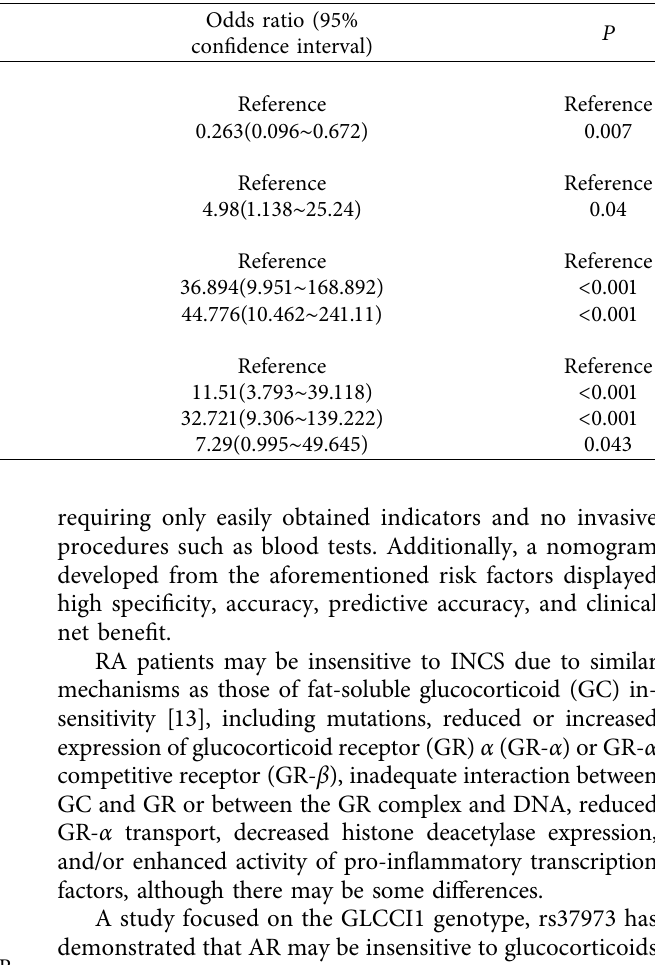
Table 2: Multivariate logistic regression